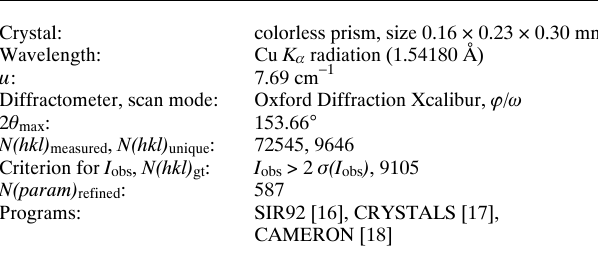
Table 2. C ontinued . Table 1. D a t a collection a nd h a